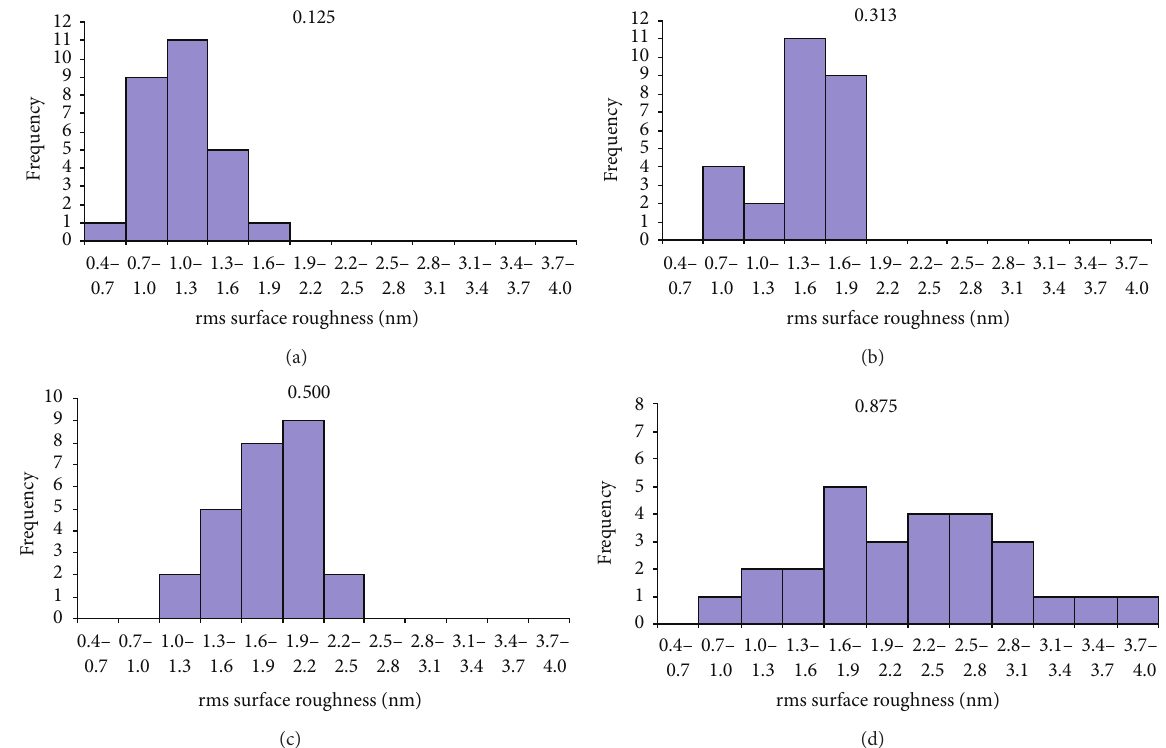
Figure 4: Histograms of the rms surface roughness values measured on 30 × 30 nm 2 areas and obtained analysing more than 20 AFM topography